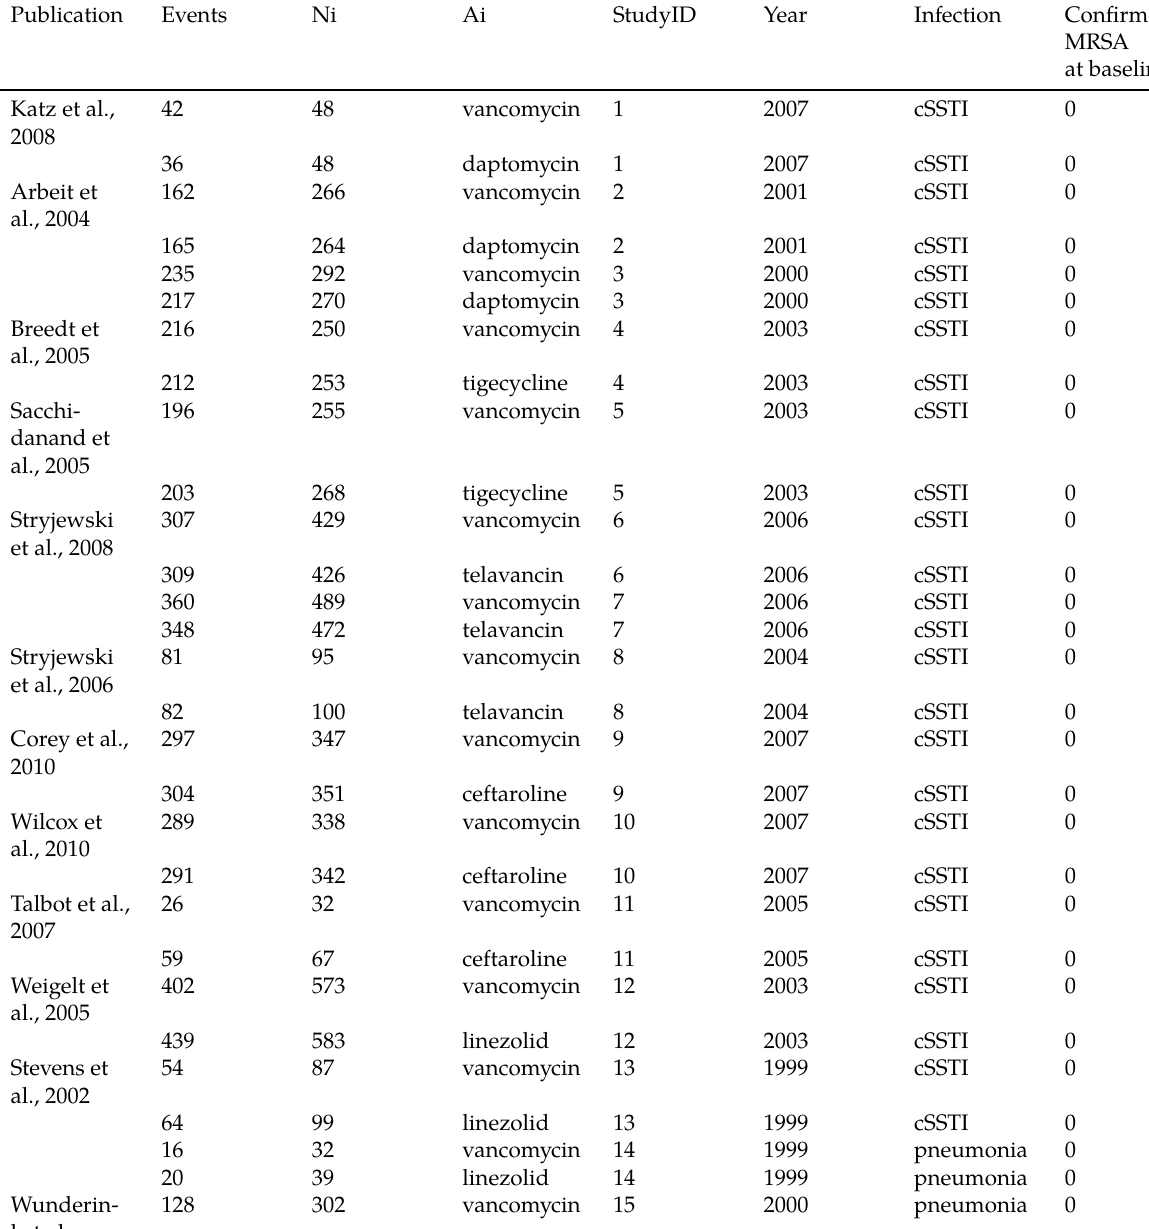
Table 3: Data extraction table for the network meta-analysis of antibiotic use on methicillin-resistant Staphylococcus aureus